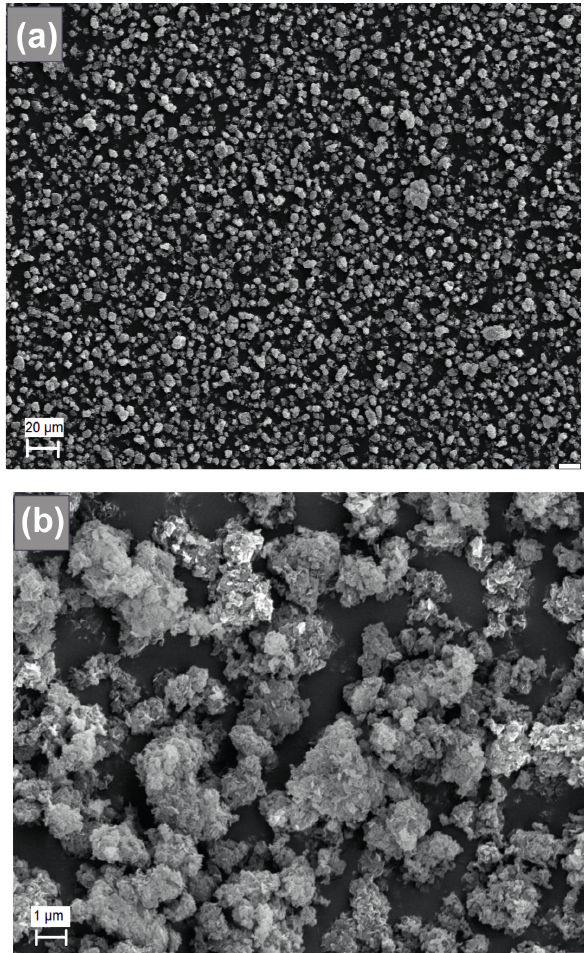
Figure 3: SEM of magnesium hydroxide.